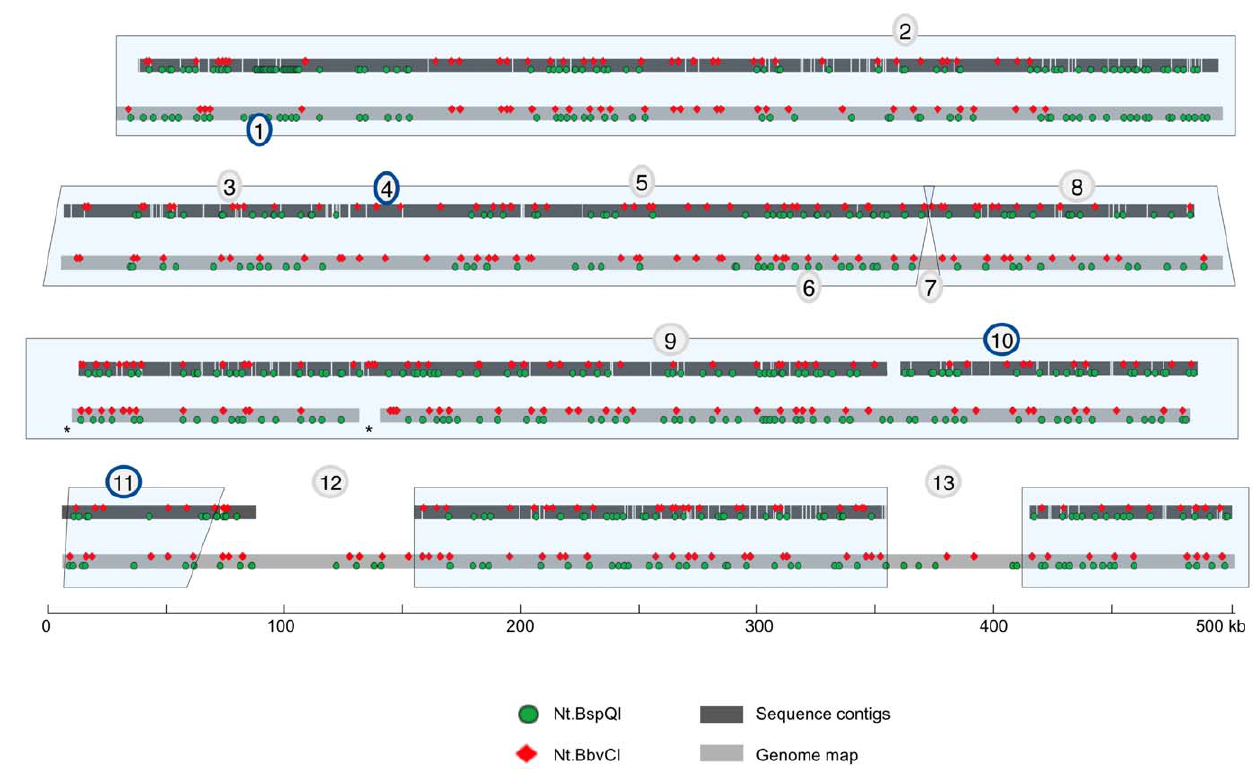
Figure 7. Comparison of the final genome map guided sequence assembly to the genome map. The final sequence assembly almost completely spans the genome map. Gaps in the genome map are denoted with asterisks.